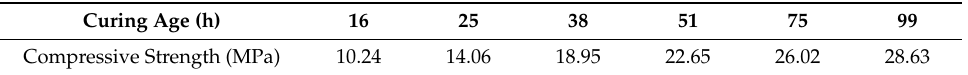
Table 3. Reference strength of the test specimen.